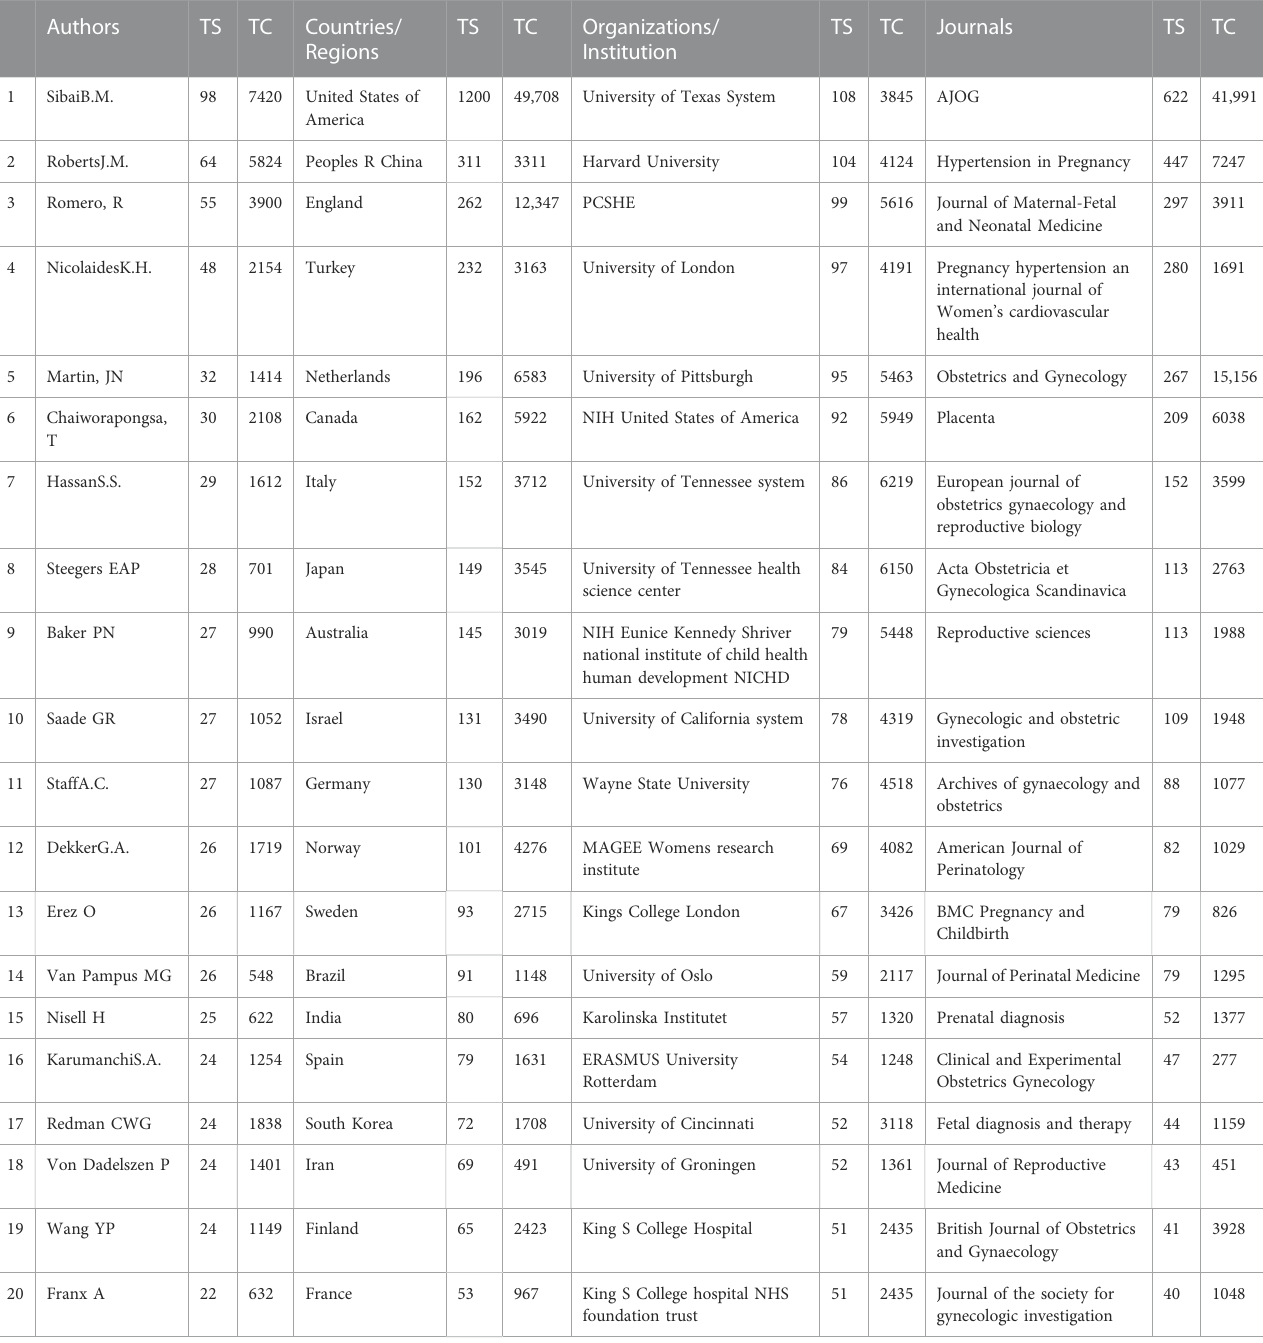
TABLE 1 The most cited authors, countries, organizations, and journals in the preeclampsia